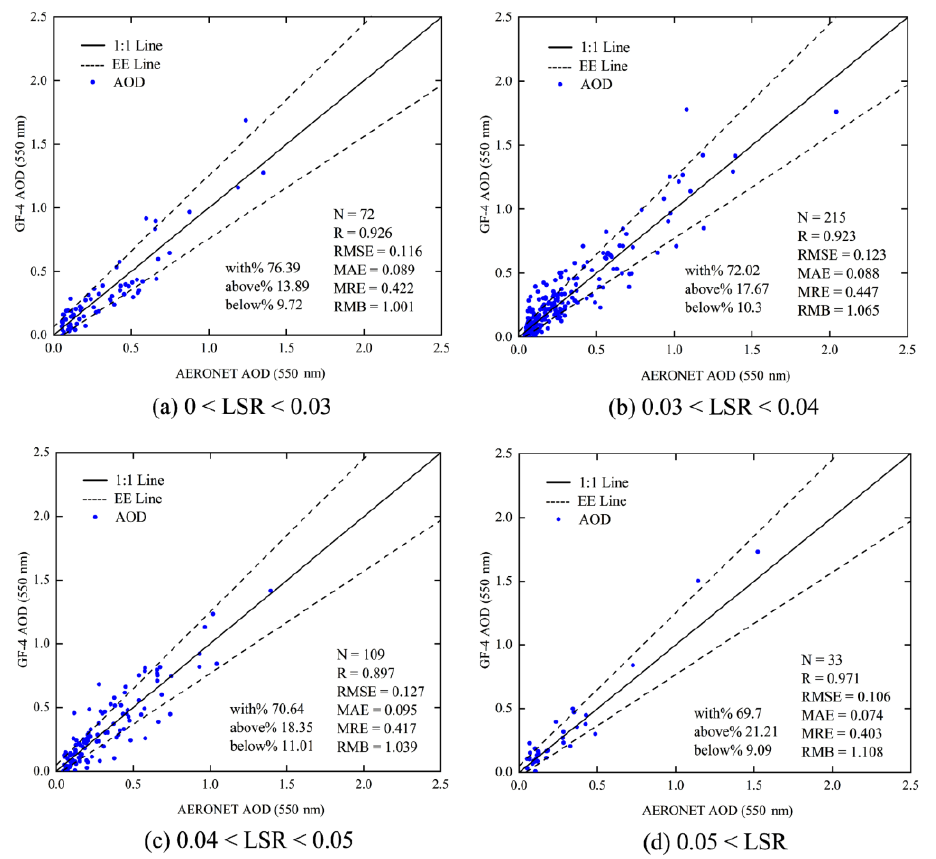
Figure 4. Validation and uncertainty analysis of GF-4 AOD retrievals compared to AERONET AOD under different LSR conditions.